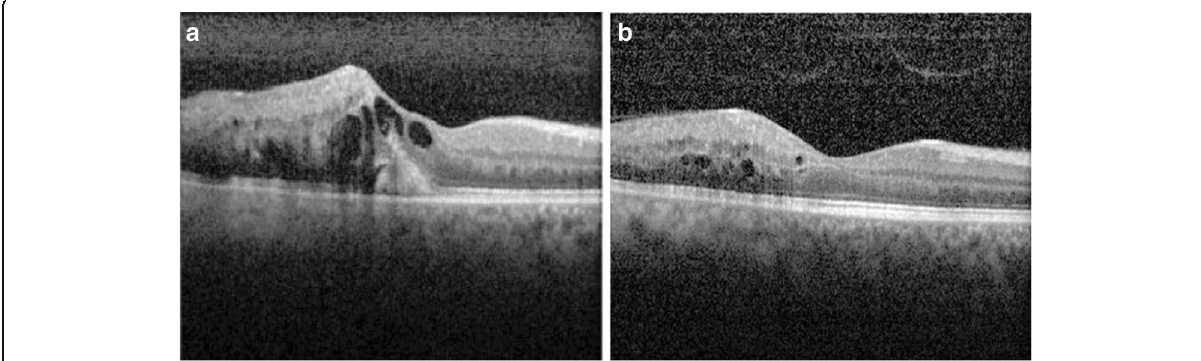
Fig. 2 a Optical coherence tomography (OCT) OD showing CME on initial presentation. b OCT OD showing improvement of CME after intravitreal injection of